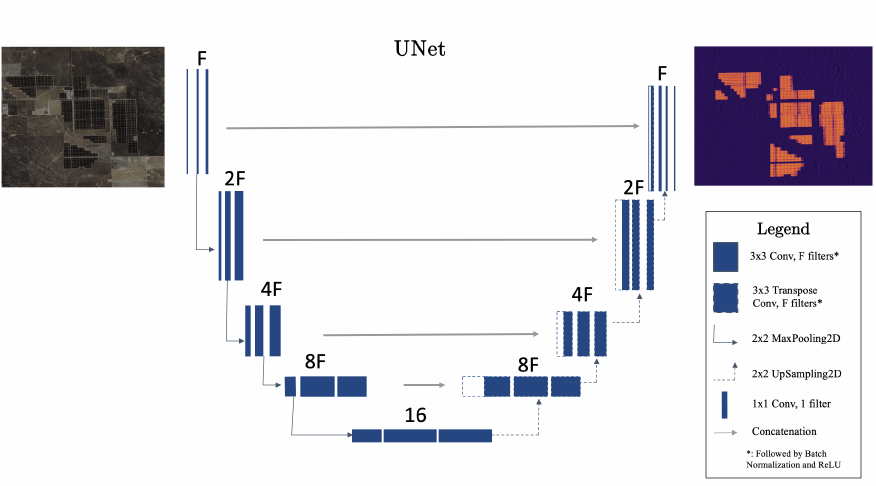
Figure 4. UNet architecture for solar farm detection. F =